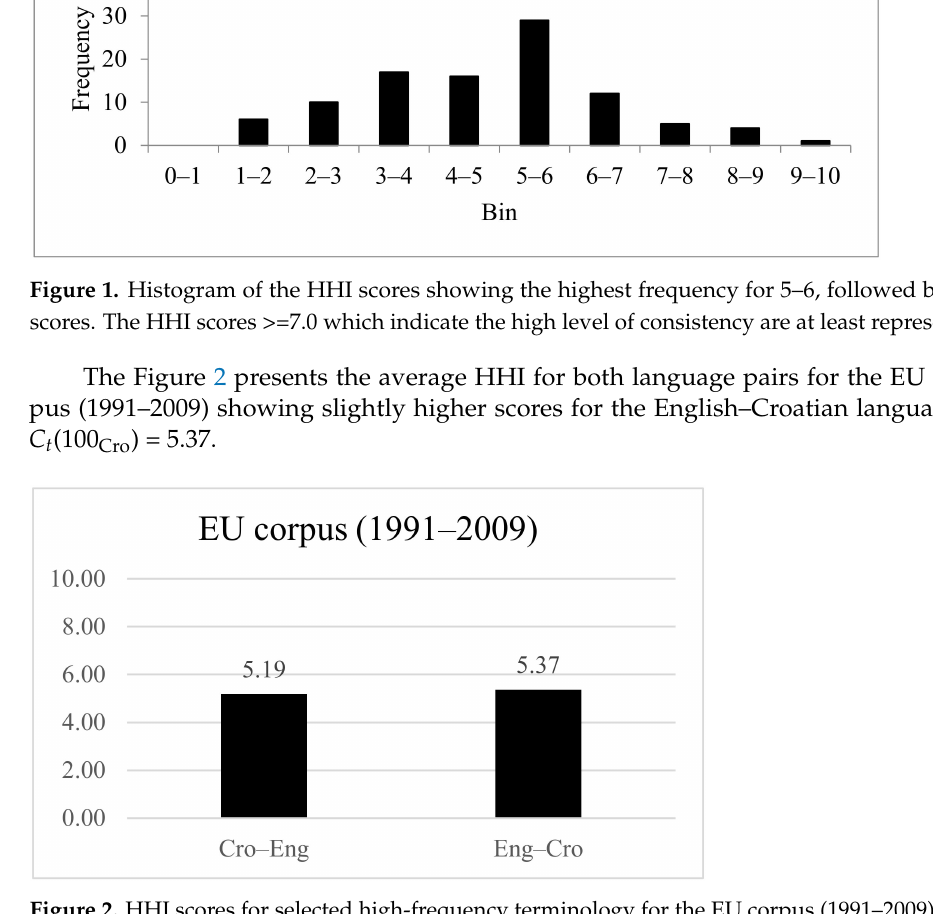
Figure 2. HHI scores for selected high-frequency terminology for the EU corpus (1991–2009) for two language